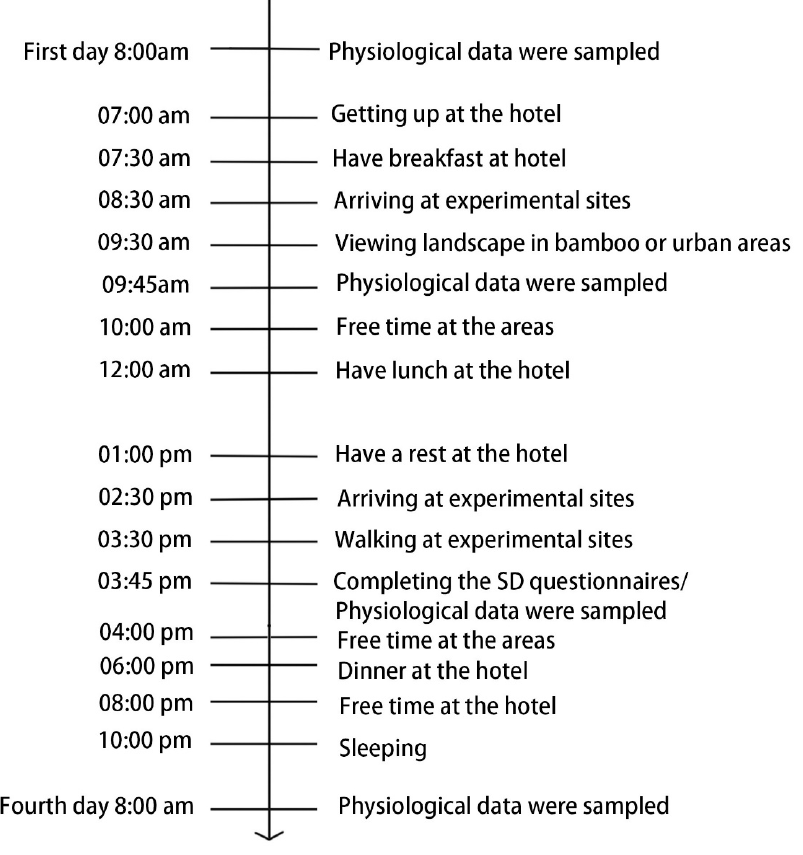
Figure 3. The itinerary for the subjects exposed to the bamboo forests or the urban